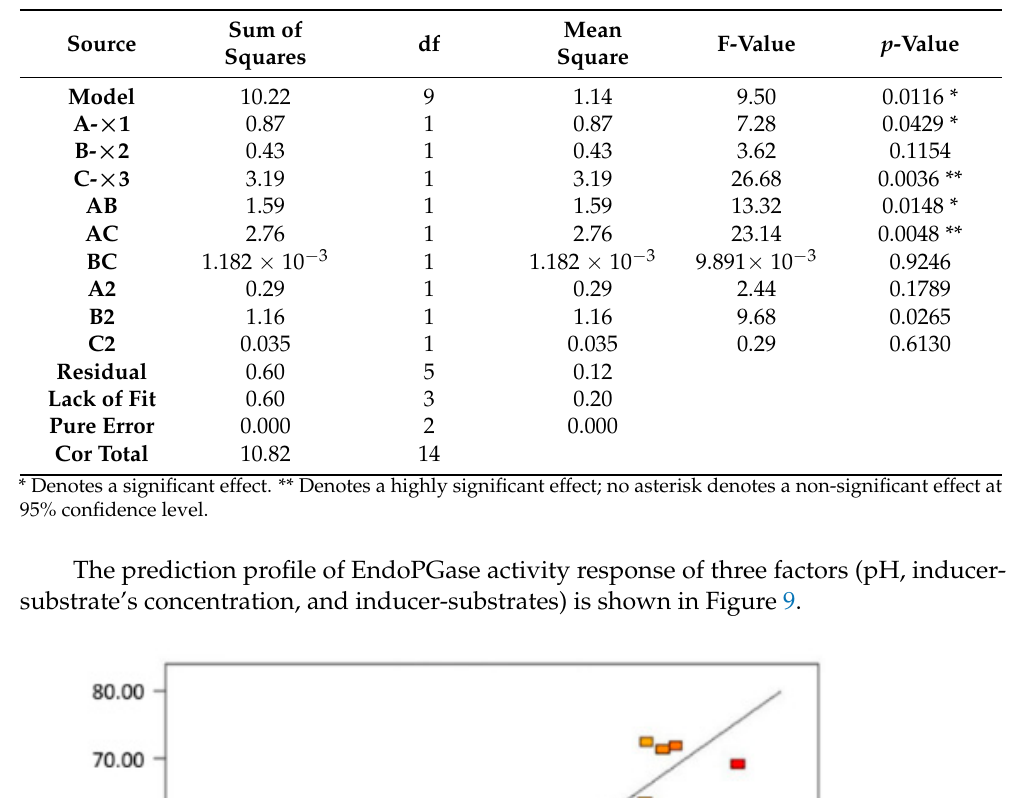
Table 1. Analysis of variance [ANOVA] table [Partial sum of squares—Type III] for response surface quadratic model.